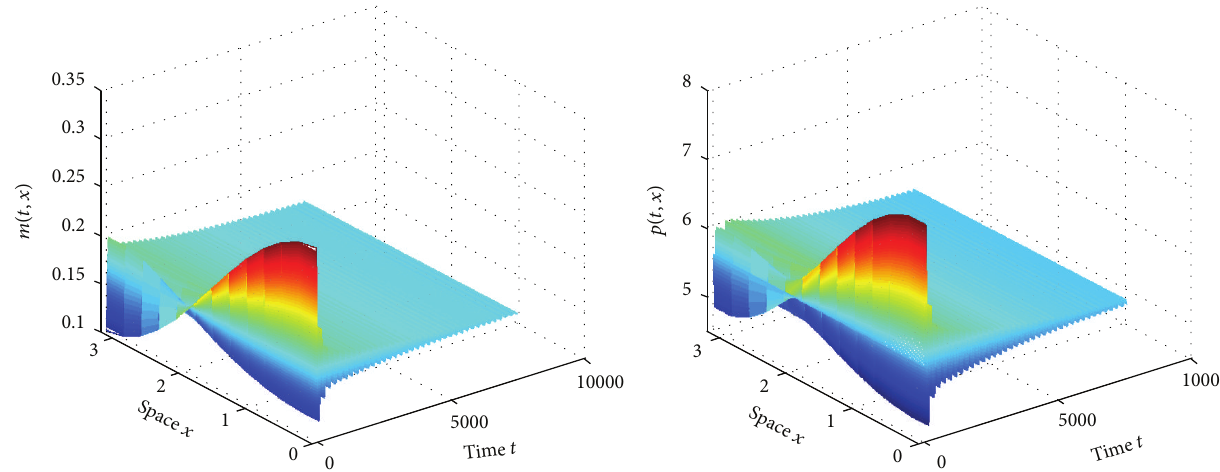
Figure 1: Numerical simulations of system (4) with 𝑑 1 = 0.002 , 𝑑 2 = 0.02 , 𝑏 = 𝑐 = 0.03 , 𝑛 = 2 , 𝑝 0 = 0.4 , and 𝜏 = 25 < 𝜏 0 0 . The initial values are 𝑚 0 (𝑥) = 0.2 + 0.1 cos 𝑥 ; 𝑝 0 (𝑥) = 5.6 − 0.01 cos 𝑥 . The positive equilibrium 𝐸 ∗ (0.1684, 5.6134) of system (4) is asymptotically stable for ∈ [0, 𝜏 0